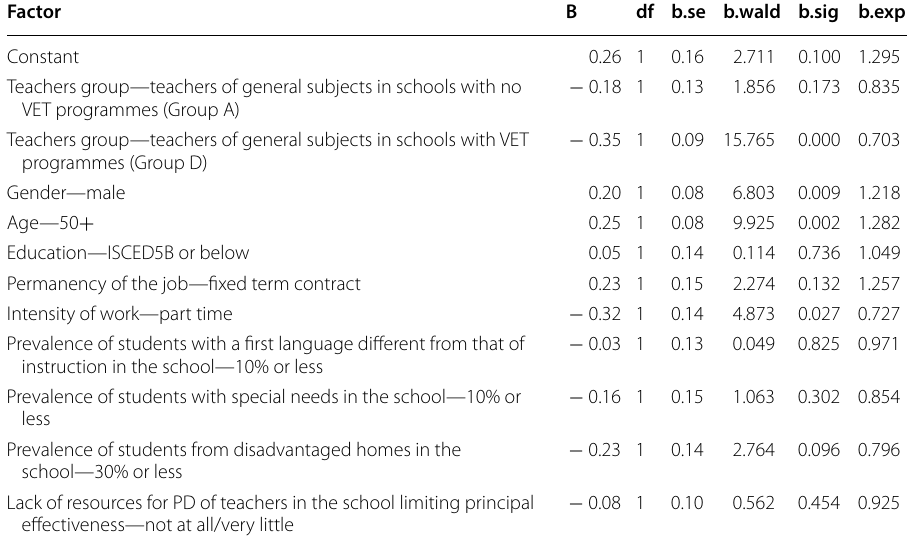
Table 17 Declaring lack of employer support as a barrier to professional development, results of the logistic regression model, regressors R1–R10, Italy, 2013 (Source: Author’s calculations based on OECD, TALIS 2013)